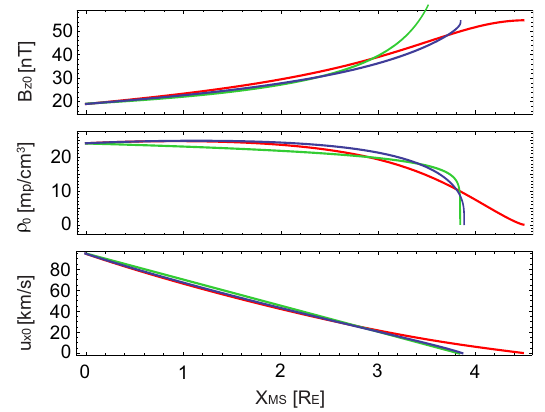
Fig. 11. Magnetosheath solutions on the stagnation streamline for the analytical (green), the numerical zeroth-order (red), and the second-order approach